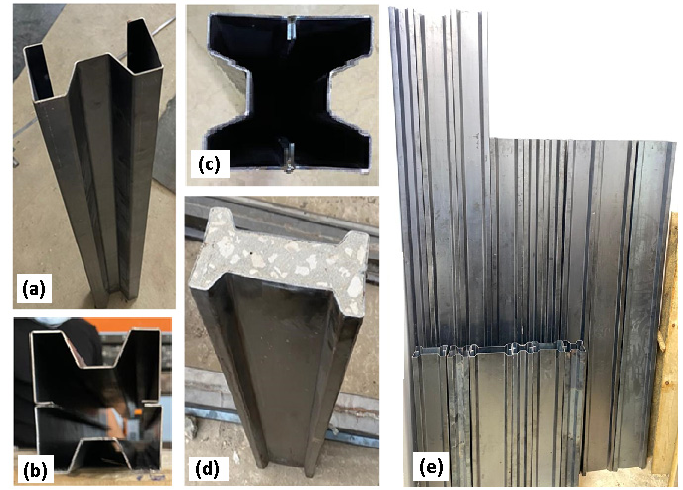
Figure 2. Specimens manufacturing process ( a ) Forming sigma sections, ( b ) assembling column section, ( c ) welding the two stigmas, ( d ) casting concrete and ( e ) all fabricated steel shells. Table 4. Summary of tested specimens’ configurations.